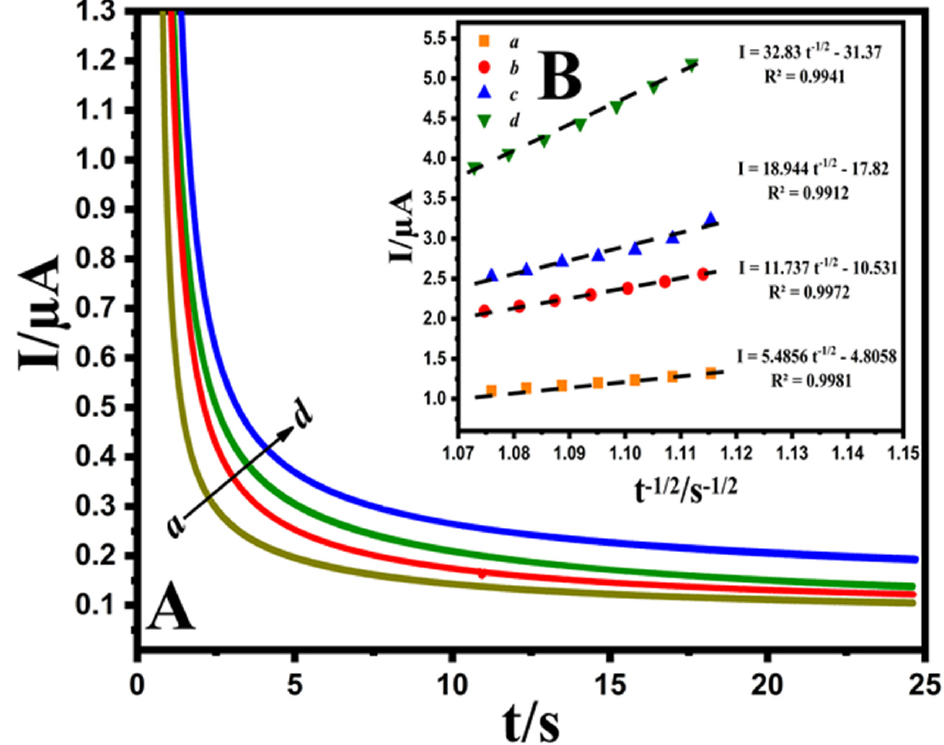
Figure 5. ( A ); Chronoamperograms obtained at the Au@NiFe 2 O 4 /SPE in the presence of ( a ) 200.0, ( b ) 300.0, ( c ) 400.0 and ( d ) 500.0 µM EPR at pH 4.0 B-R buffer. ( B ); Plots of I vs. t − 1/2 derived from chron- oamperograms.